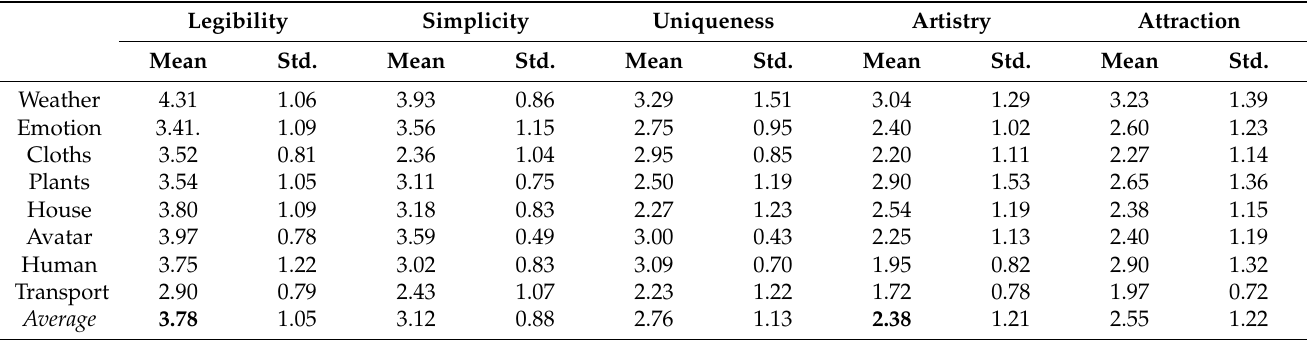
Table 4. Quantitative metrics of our model from the user perceptual